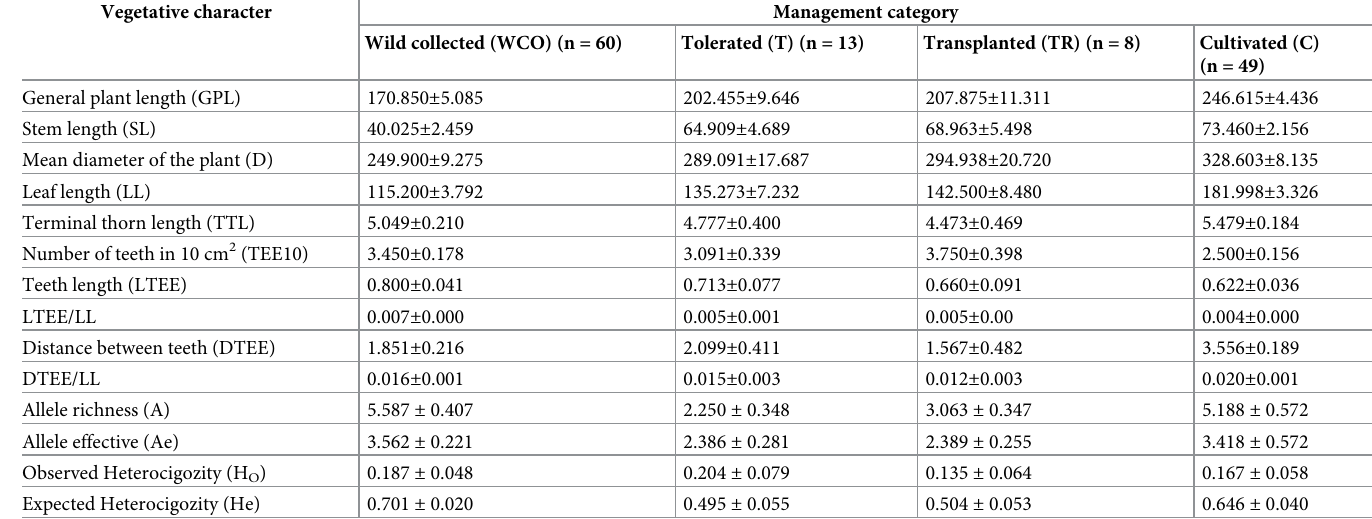
Table 5. Vegetative morphological characteristics according to the management categories of the eight traditional varieties of pulque agaves, identified by produc- ers in the localities of La Coyotera and El Cubo , in the state of Hidalgo. Vegetative